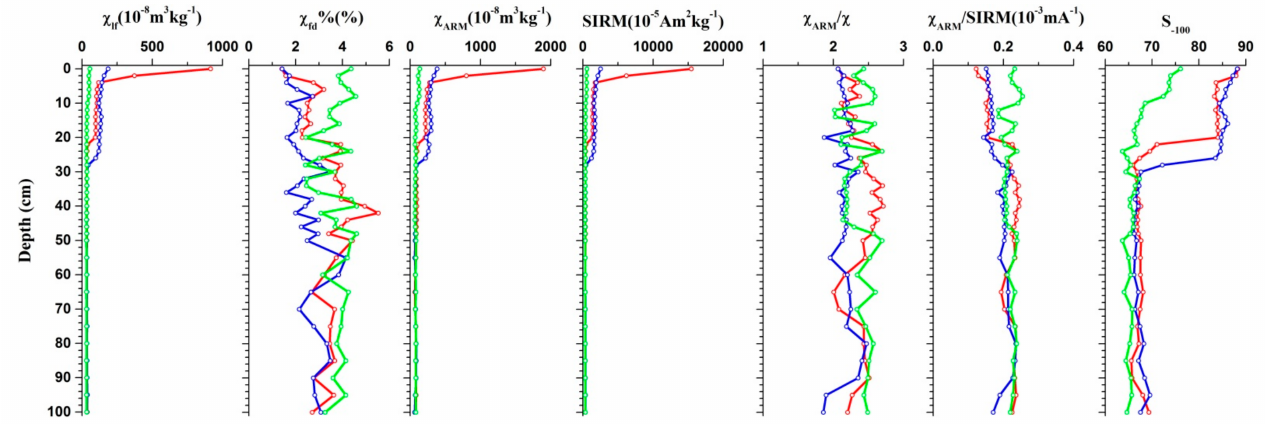
Figure 3. Magnetic parameters of vertical soil profiles: profile 1 was shown in green; profile 2 was shown in blue; profile 3 was shown in